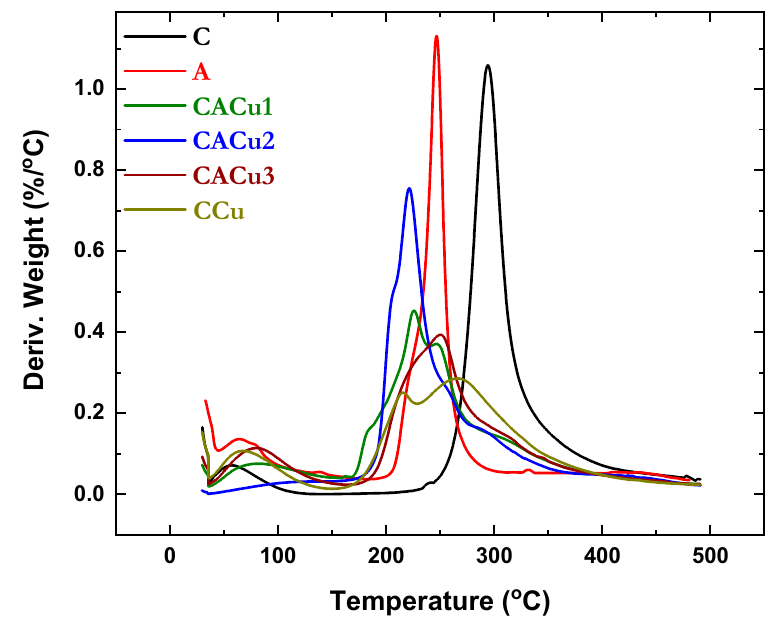
Figure 3. Derivative plot from TGA for the biopolymers (C, A), ternary composites (CACu1, CACu2, CACu3) and a binary composite (CCu) material.